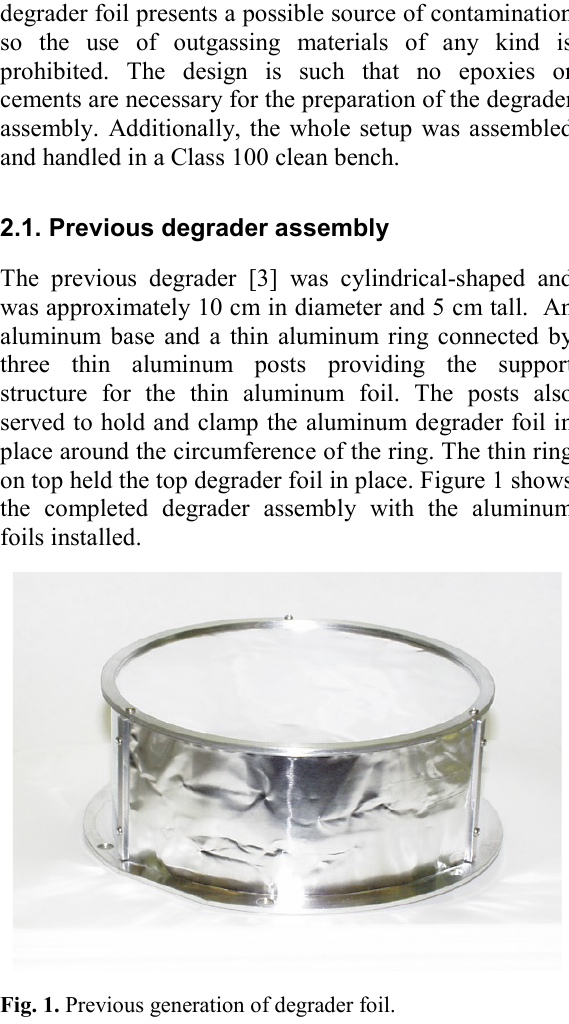
Fig. 1. Previous generation of degrader foil.